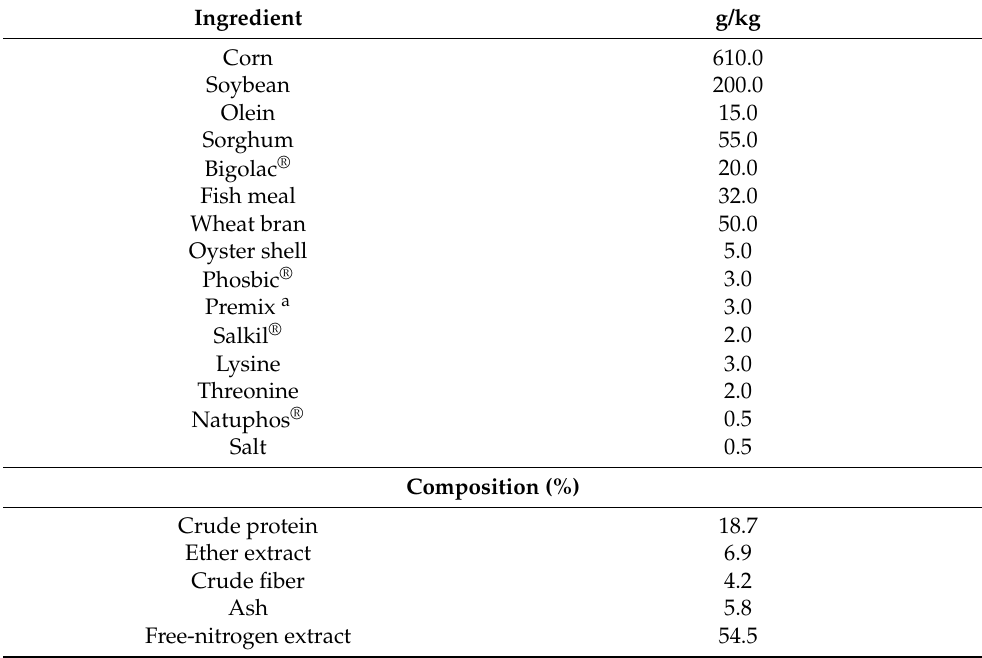
Table 1. Diet composition (as-fed